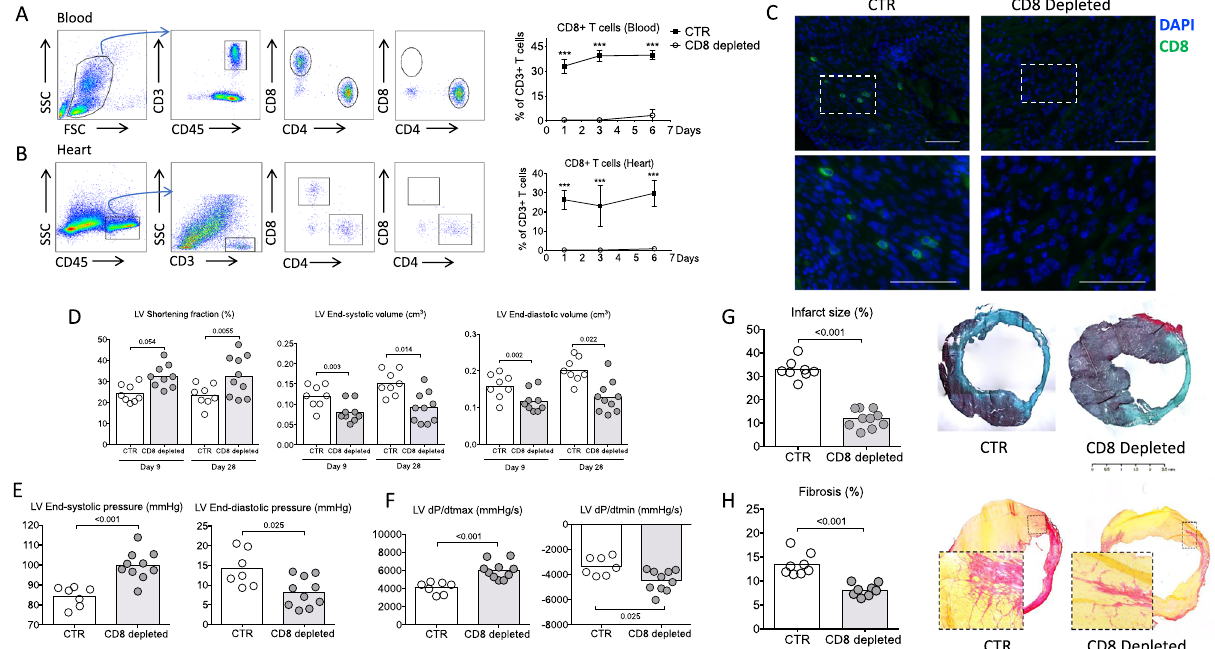
Fig. 2 CD8 T cell depletion improves heart function and reduces infarct size. A Representative examples (left) and quantitative analysis (right) of CD8 + T cell staining in the blood of C57BL/6J mice treated with isotype control (CTR, black box) or with the CD8 mAb (CD8 depleted, white circle) ( n = 6 mice per group/time point); data are presented as mean± SEM, *** P < 0.001. B Representative examples (left) and quantitative analysis (right) of CD8 + T cell staining in the heart of C57BL/6J mice treated with isotype control (CTR) or with the CD8 mAb (CD8 depleted) ( n = 6 mice per group/time point); data